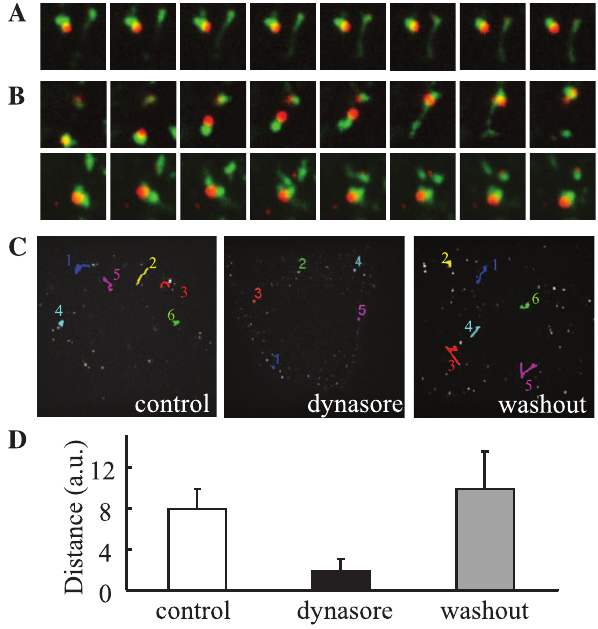
Figure 3. Dynasore inhibits tubule fission and endosomal motility. HeLa cells were bound on ice with Alexa555-EGF and Alexa488-transferrin, rinsed, and transferred to 37 u C. After 5 min, dynasore was added, and the cells were incubated further for another 25 min. For washout, the cells were rinsed at 30 min with dynasore-free media. Live images were taken just before washout ( A ) and at 10 min after washout ( B ). Frames were captured every 2 sec for a total of 2 min 30 s (See also Movie S3 ). C , Movements of EGF-positive endosomes for 90 s were manually tracked and are illustrated. D , The mean total movement distance of EGF-positive endosomes for 2 min. 20 endo- somes were measured from 4 cells; Error bar, S.D.